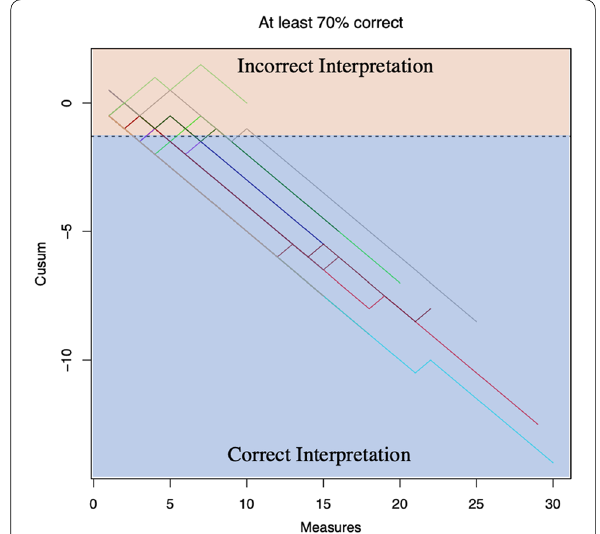
Fig. 1 Cusum plot for number of scans required to reach